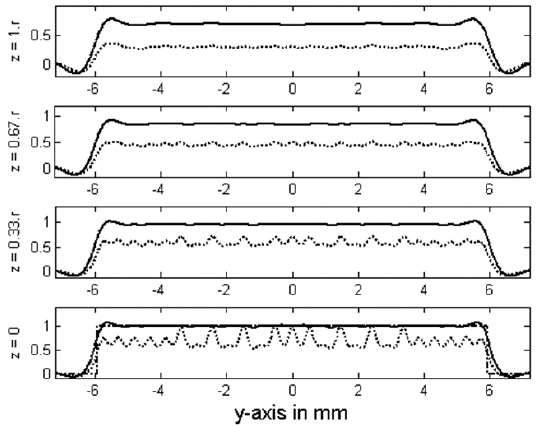
Figure 8. The normal velocity variation on the transducer surface (bottom figure) and near it (the other three figures), ‘ z ’ is the distance from the transducer face; solid line—computed results using source clusters, as shown in Figure 3; and dashed line—computed by superimposing individual point source contributions, as shown in Figure 1.